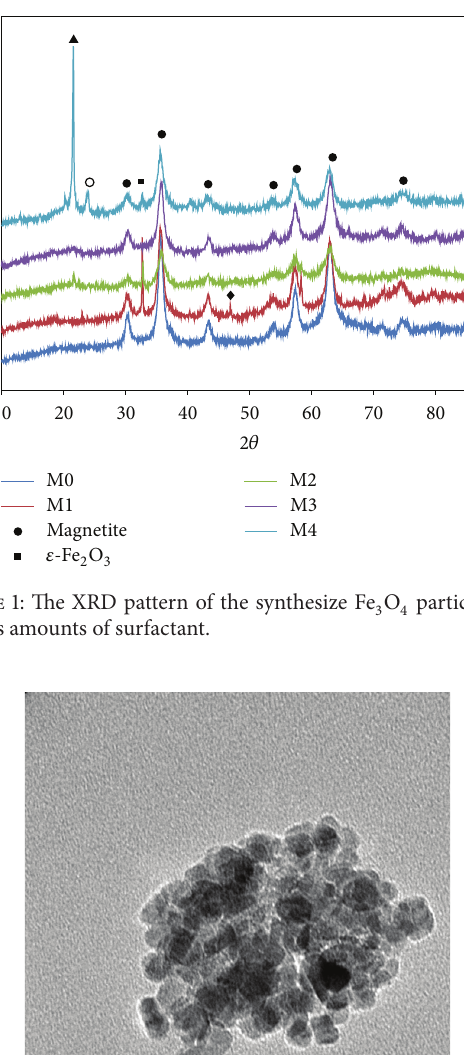
Table1:ThedefinedexperimentalsetsforFe with variations in lauric acid amount and defined experimental sets for toner synthesize with various types of Fe